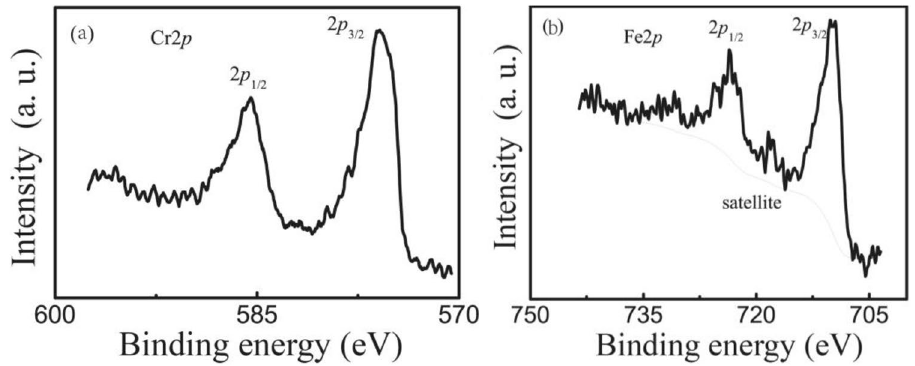
Figure 2. The core level XPS spectra for constituent elements in bulk BSCFO ( a ) Cr 3+ and ( b ) for Fe 3+ .